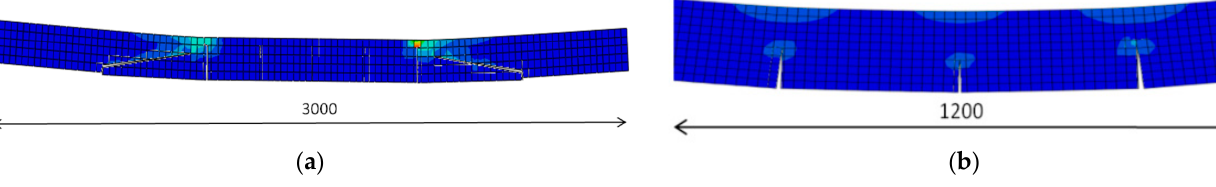
Figure 13. Crack distributions of composite slabs in numerical model (mm). ( a ) Cracks developed in the whole length of composite slabs; ( b )Cracks in the middle of composite slabs. composite slabs; ( b ) Cracks in the middle of composite